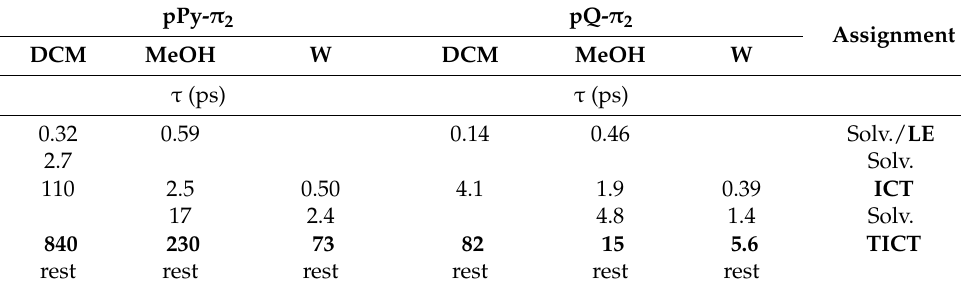
Figure 2. Femtosecond transient absorption (fs-TA) measurements of compound pPy- π 2 in DCM ( left ), MeOH ( middle ), and W ( right ) obtained by pump-probe experiment ( λ exc = 400 nm): panel A, experimental 3D matrix reporting color-coded ∆ A as a function of wavelength and time ( ∆ A > 0 yellow-orange, ∆ A < 0 blue); panel B, representative spectra at different delay times and representative kinetics (inset) at different wavelengths, together with steady-state absorption (gray-shaded area) and fluorescence (red-shaded area); panel C, EAS (evolution-associated spectra) obtained by Global Analysis. Table 2. Fs-TA results of compounds pPy- π 2 and pQ- π 2 in DCM, MeOH, and W obtained by Global